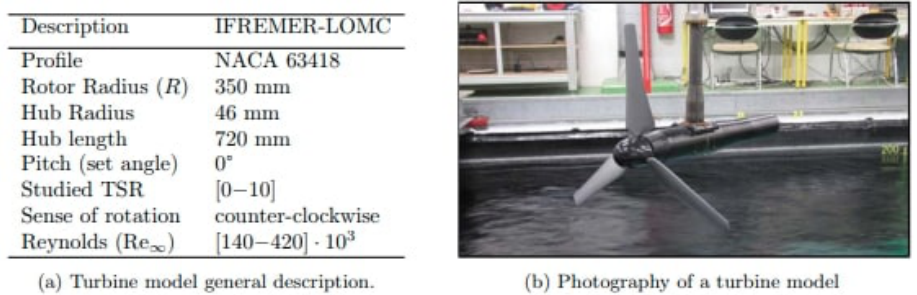
Figure 1. General characteristics ( a ) and design ( b ) of the IFREMER-LOMC turbine [21], University of Le Havre,